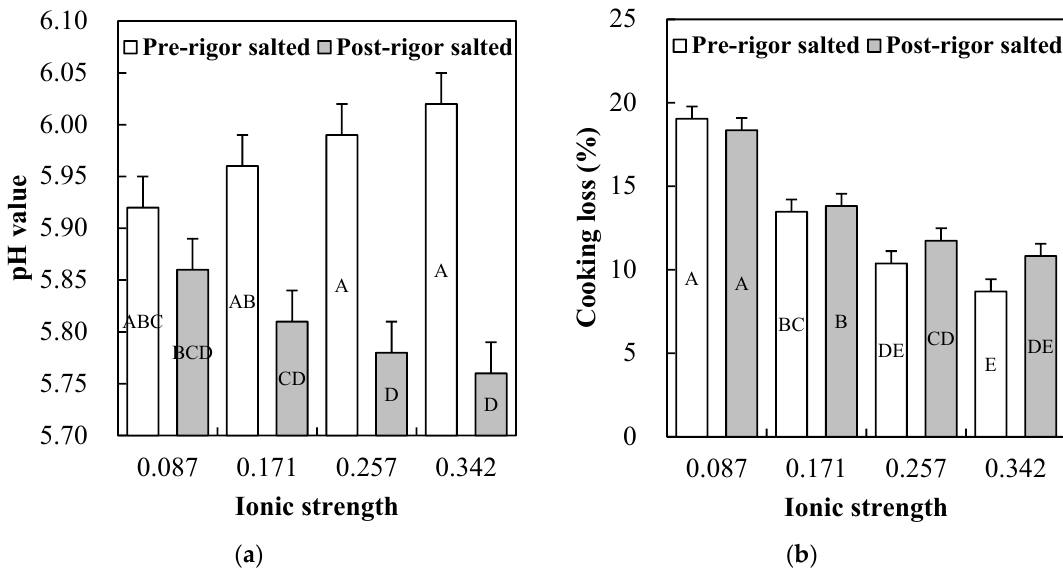
Figure 1. Rigor status (pre- vs. post-rigor salted) × ionic strength (0.087, 0.171, 0.257 vs. 0.34) interaction effects on pH value ( a ) and cooking loss ( b ) of salted chicken breasts. Error bars represent standard error of the means. A–E: means with the same letter are not significantly different ( p ≥ 0.05).